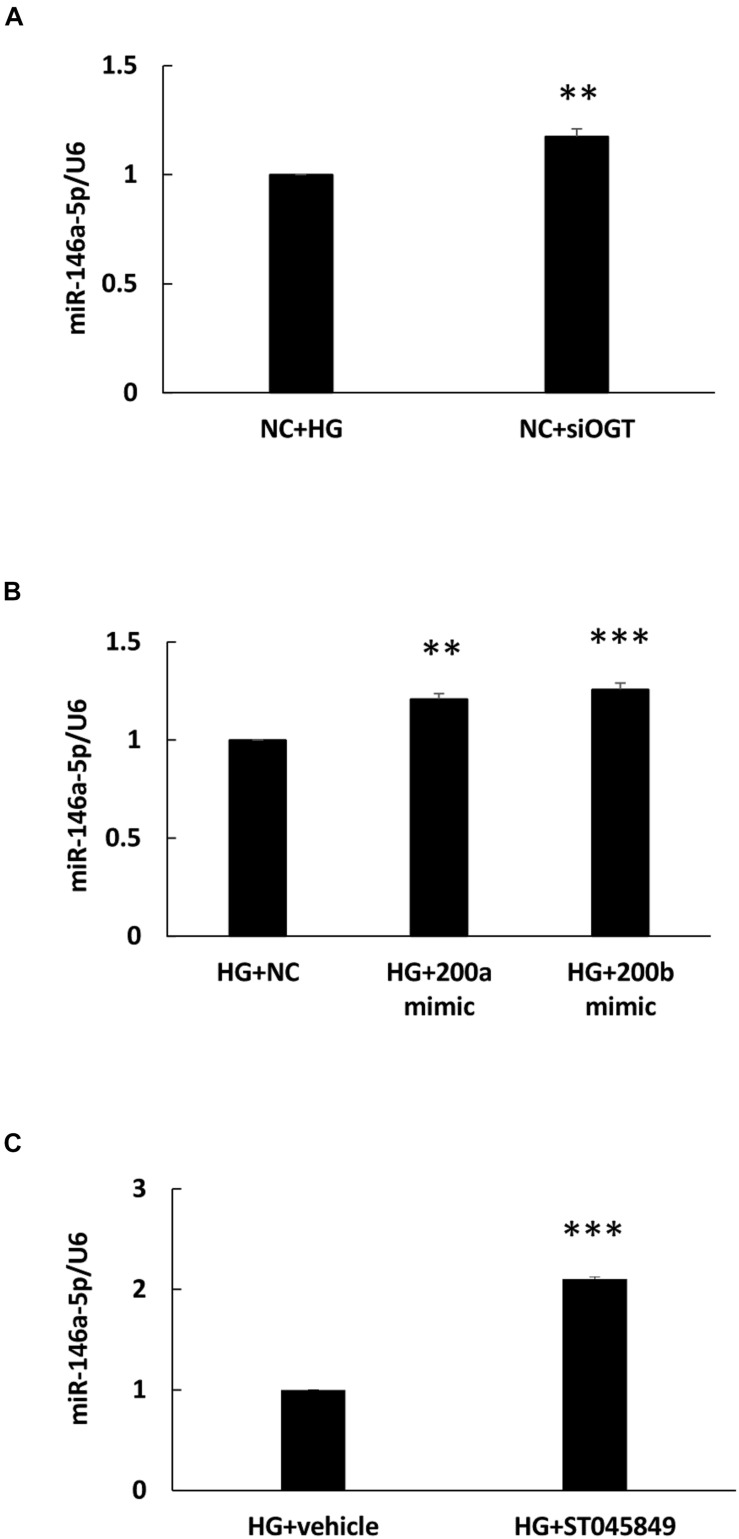
(A–C) HG-treated endothelial miR-146a expression level were increased by OGT siRNA transfection, miR-200a/miR-200b mimic transfection, and ST045949. (A) Real-time PCR revealed that OGT siRNA transfection induced 1.18-fold increases in miR-146a-5p expression levels, N = 3. **p < 0.01 compared with HG-treated HAECs transfected with a negative control (HG + NC). (B) Real-time PCR revealed that miR-200a/200b mimics transfection induced 1.21- and 1.26-fold increases in miR-146a-5p expression levels. N = 4. **p < 0.01 compared with HG + NC. ***p < 0.001 compared with HG + NC. (C) Real-time PCR revealed that ST045849 pretreatment induced 2.1-fold increases in miR-146a-5p expression levels. N = 5. ***p < 0.001 compared with HG-treated HAECs pretreated with vehicle.